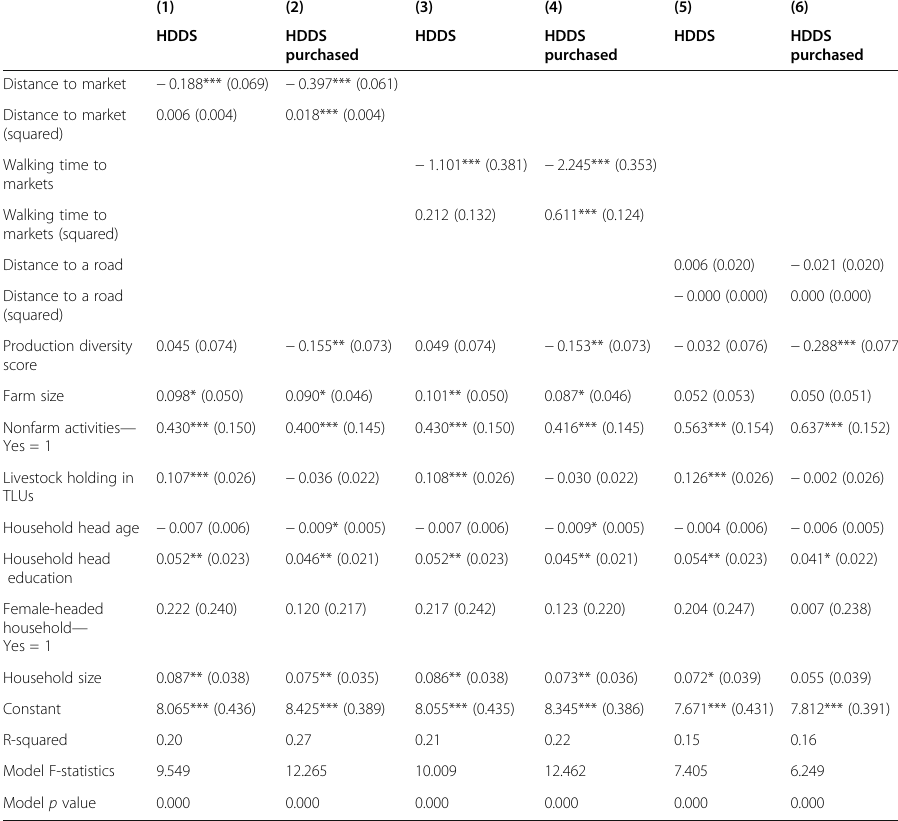
Table 2 Association between market access and HHDS for 324 smallholder